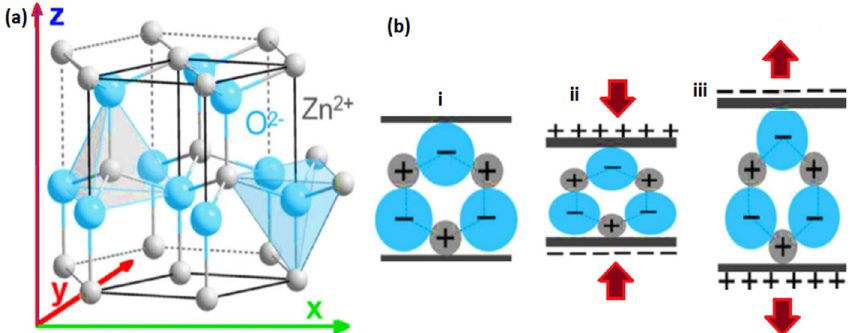
Figure 10. ( a ) Lattice structure of wurtzite ZnO. ( b ) Sketch of a wurtzite ZnO lattice at rest ( i ), under compressive ( ii ) and tensile ( iii ) stress, highlighting the change in the internal charge distribution of the lattice. Reprinted with permission from ref. [94]. Copyright 2019 John Wiley and Sons.